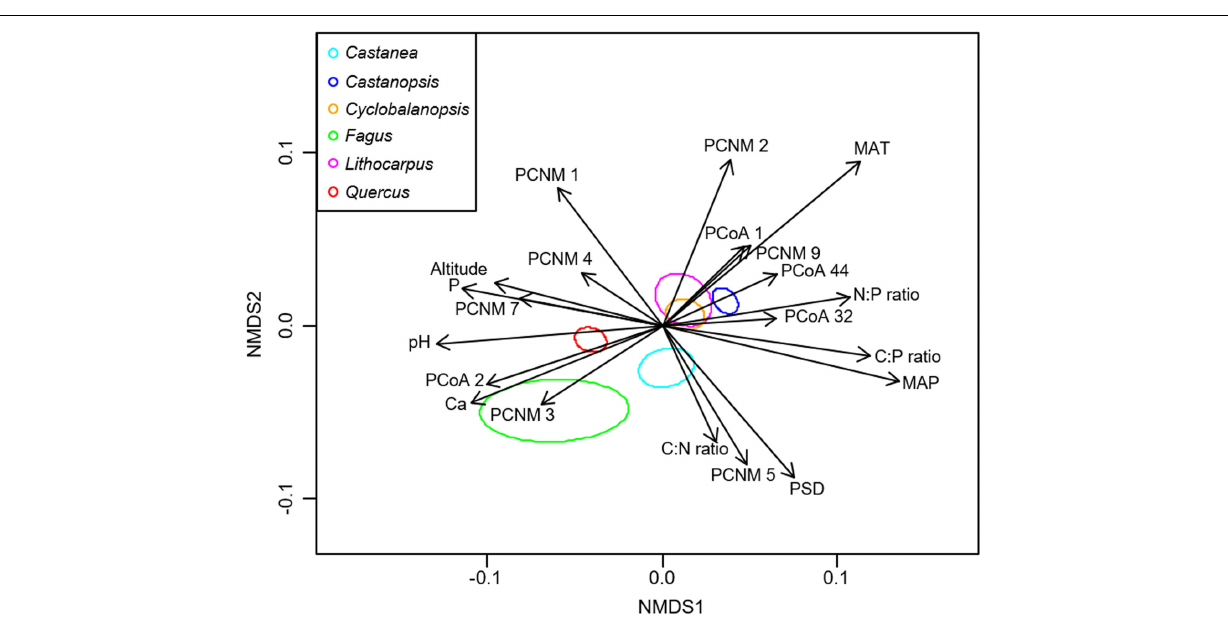
FIGURE 2 | Non-metric multidimensional scaling (NMDS) of the ectomycorrhizal fungal community composition. Significant host and abiotic variables were fitted as vectors onto the NMDS graph ( P ≤ 0.001, R 2 ≥ 0.05). Ellipses indicate 95% confidence intervals around centroids for each plant genus (stress = 0.208, R 2 = 0.207, P < 0.001). C, total soil carbon; N, total soil nitrogen; P, total soil phosphorus; Ca, total soil calcium; PSD, particle size distribution; PCNM, principal coordinates of neighbor matrices. PCoA, principal coordinate analysis of host phylogeny; MAT, mean annual temperature; MAP, mean annual